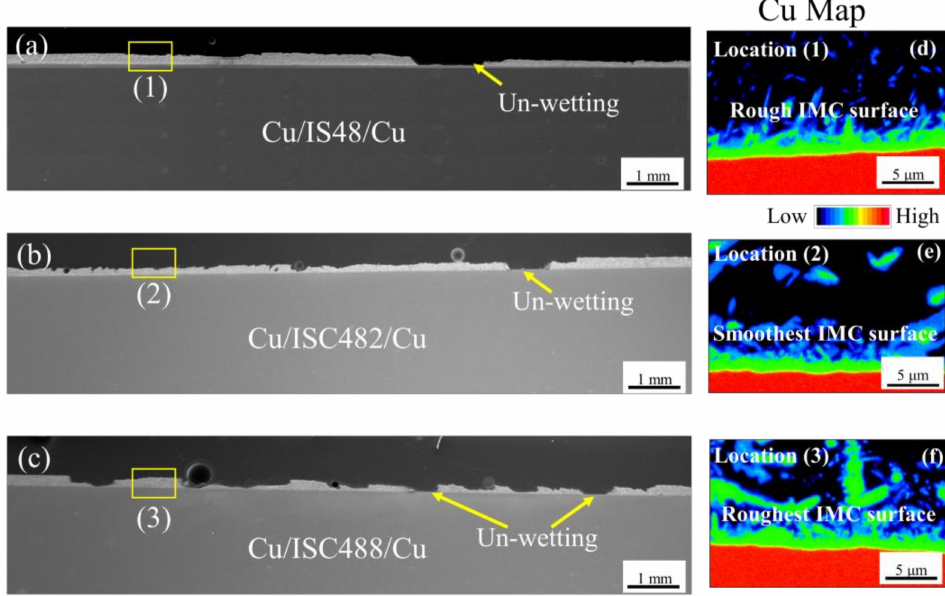
Figure 8. SEM images of typical cross-sectional fractured samples of ( a ) Cu/IS48/Cu, ( b ) Cu/ISC482/Cu, and ( c ) Cu/ISC488/Cu joints. ( d – f ) EPMA Cu map images of typical loca- tions (1, 2, and 3) at the interface of the fractured